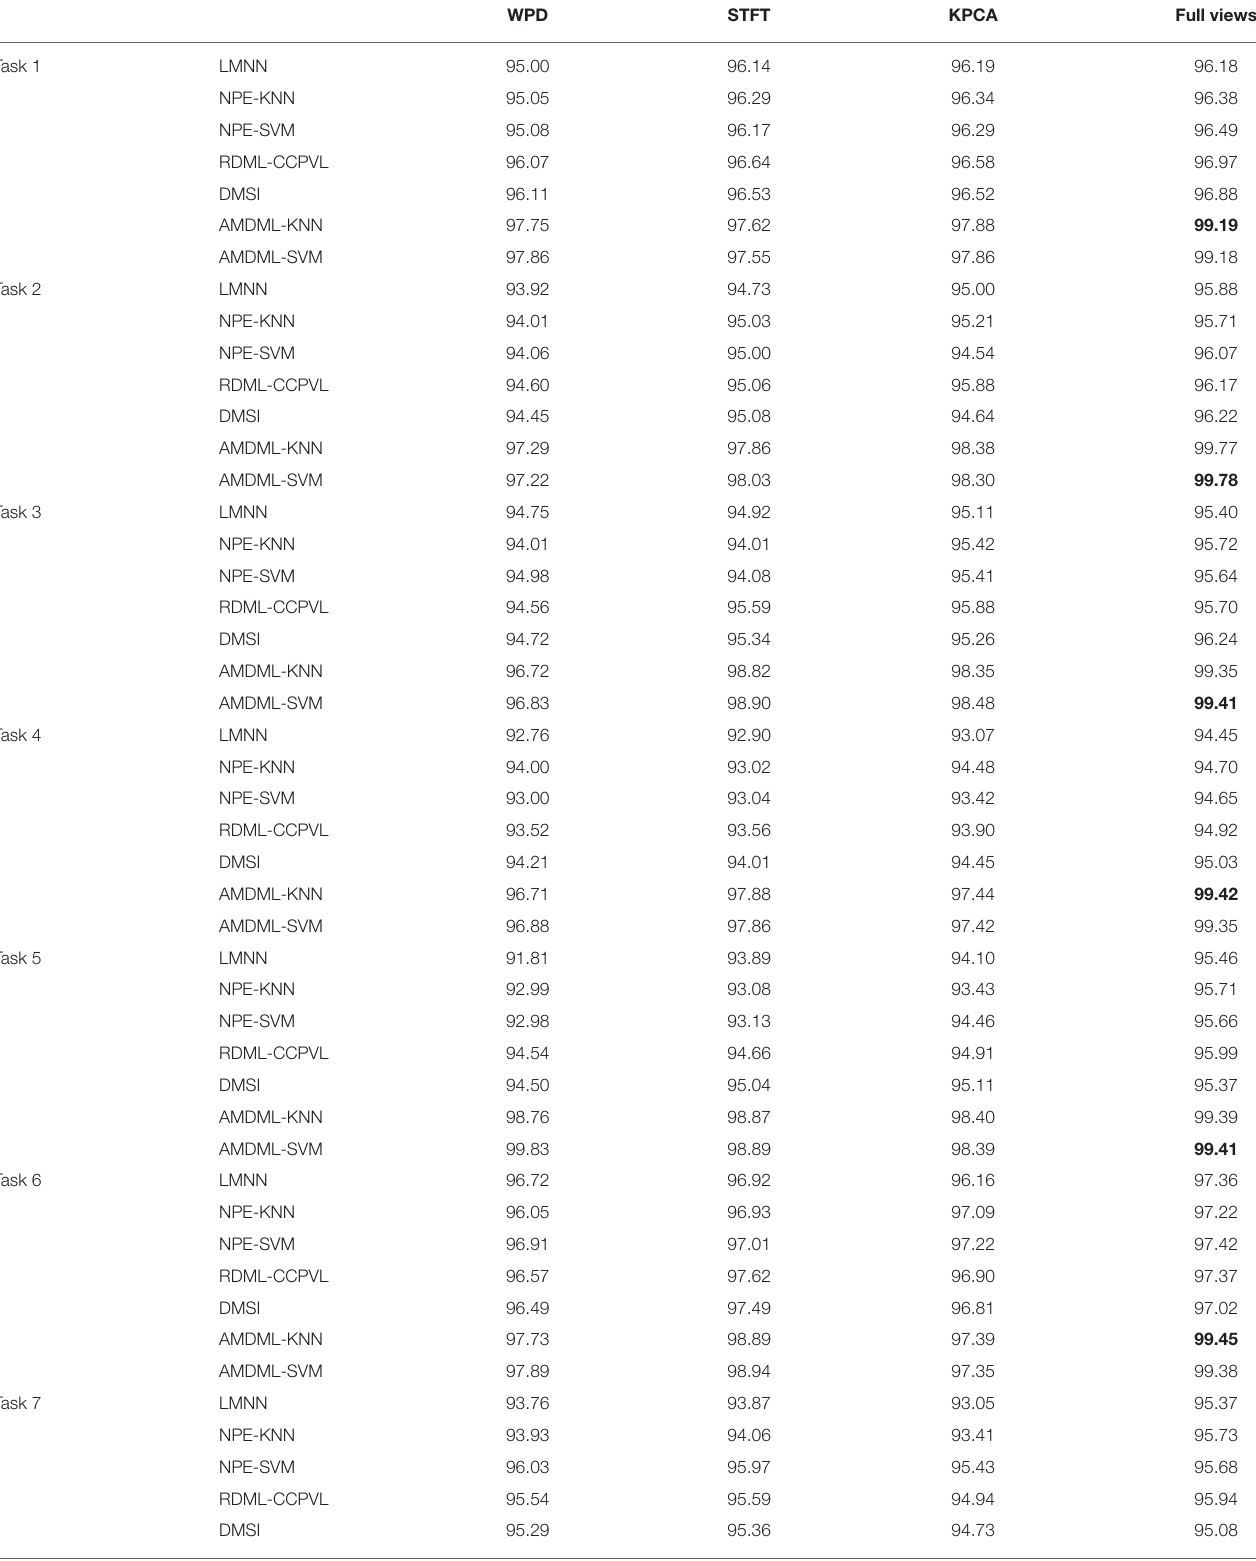
TABLE 3 | The classification performances of AMDML on 10 classification tasks. WPD STFT KPCA Full